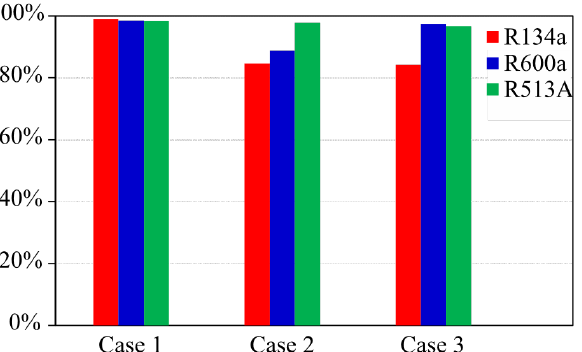
Figure 7. Reductions of the wire-on-tube condenser area for the use of the three refrigerants.